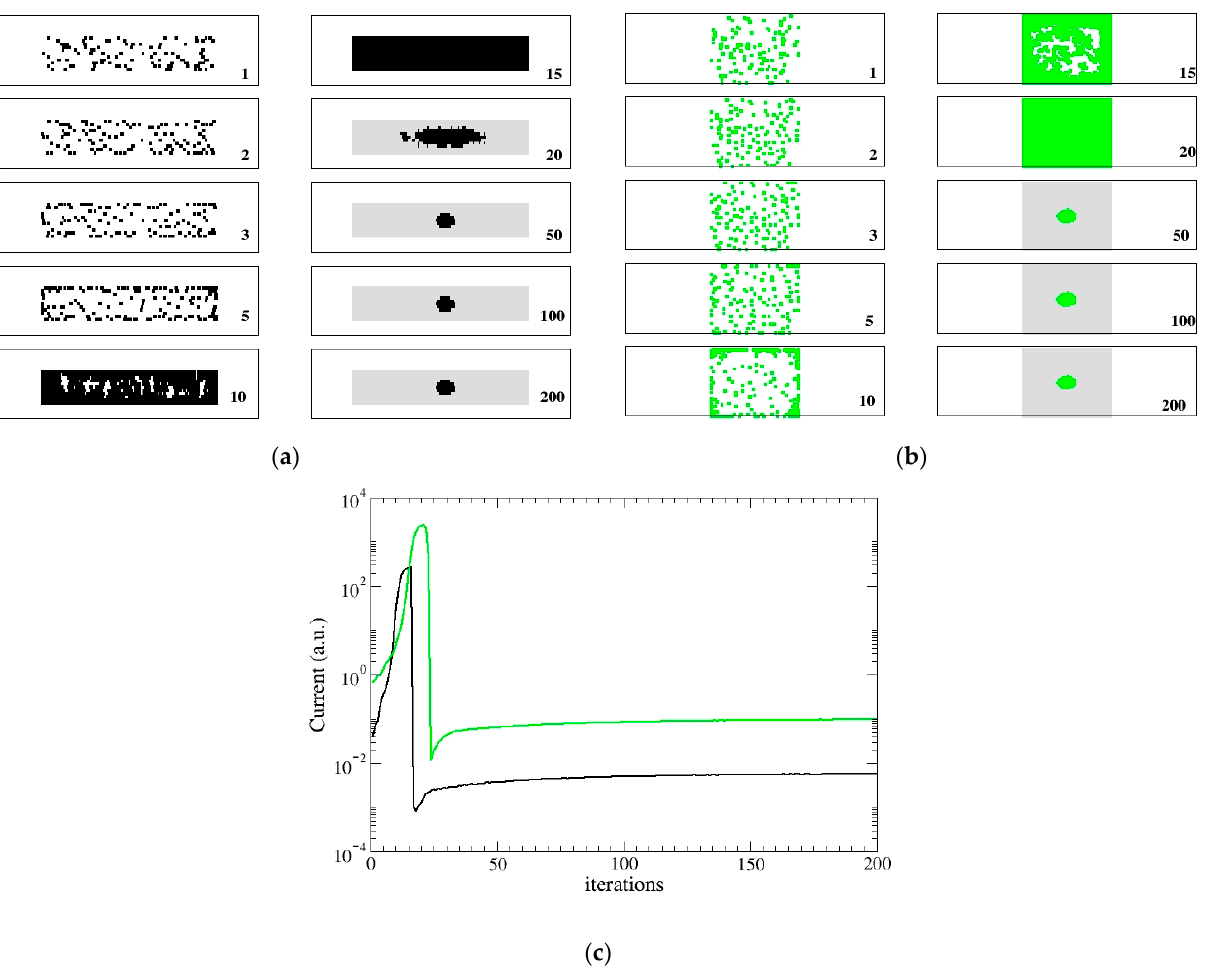
Figure 5. Biofilm formation. Two different geometries are sketched: ( a ) 200 × 10 and ( b ) 50 × 50. In both cases, the same evolution conditions are applied, i.e., equal initial number of seeds (5% of total amount) with a small rate of reproduction ( σ = 22), in the black and STATIC scenario. ( a ) Screenshots of the sample of bacteria at different evolution time from 1 to 200. Alive bacteria (black) and biofilm (gray) co-exist. ( b ) Screenshots of the sample of bacteria at different evolution times from 1 to 200. Alive bacteria (green) and biofilm (gray) co-exist. ( c ) QS signal. The electrical current of the network mirrors the QS for the development of a colony (black for rectangular network, green for square network).